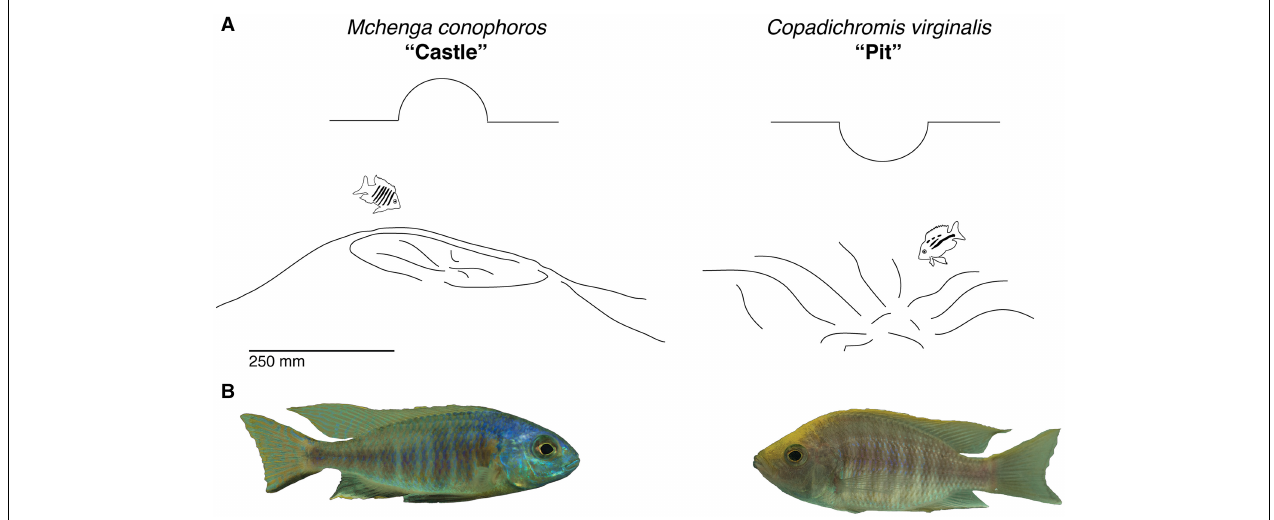
FIGURE 2 | Basic bower types. (A) Castle and pit phenotypes as represented by the species Mchenga conophoros and Copadichromis virgnalis. (B) Photos of male Mchenga conophoros and Copadichromis virginalis .